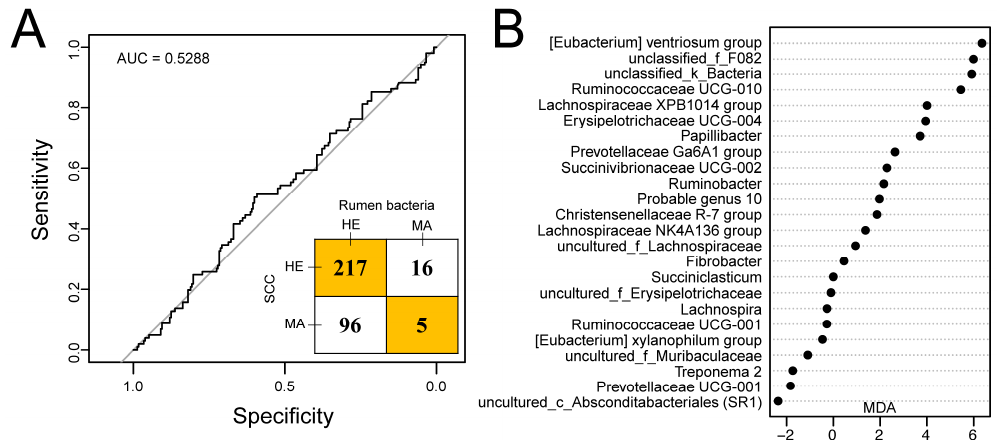
Figure 5. Predicting udder health status outcome using random forest model by using a rumen bacteria dataset of 334 dairy cows [24]. ( A ) Receiver operating characteristic (ROC) curve